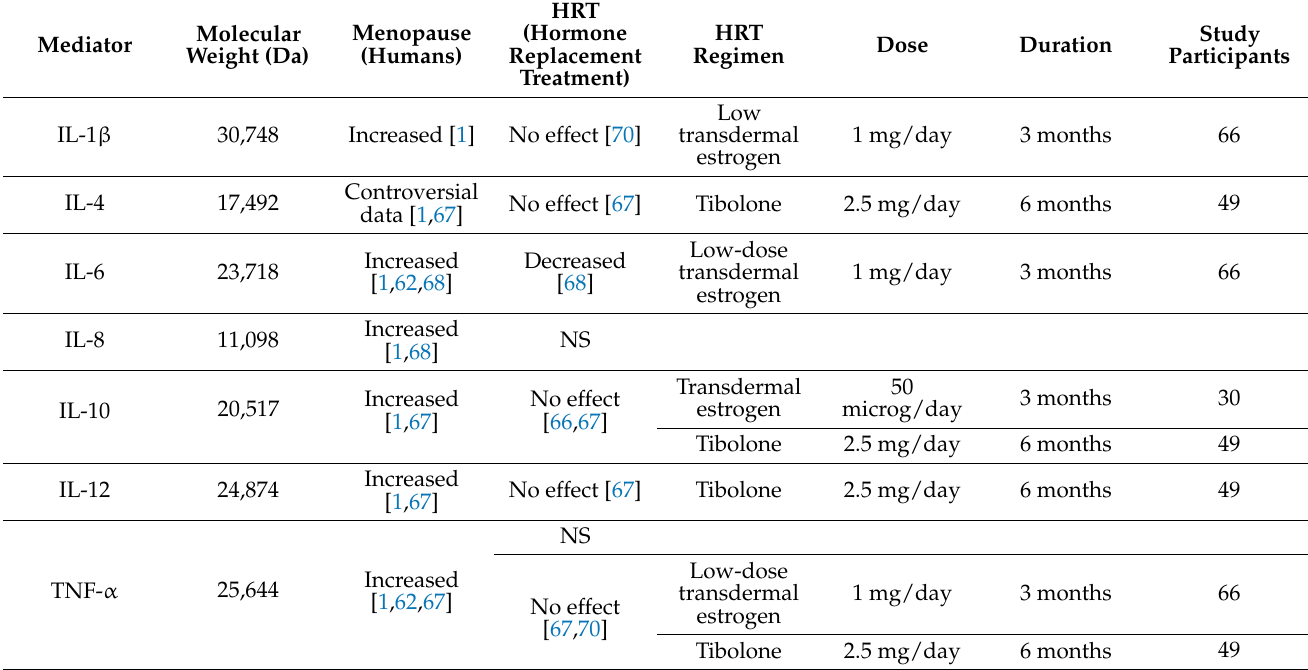
Table 1. Inflammatory molecule actions in menopausal women and after HRT use for menopause (NS: not studied).